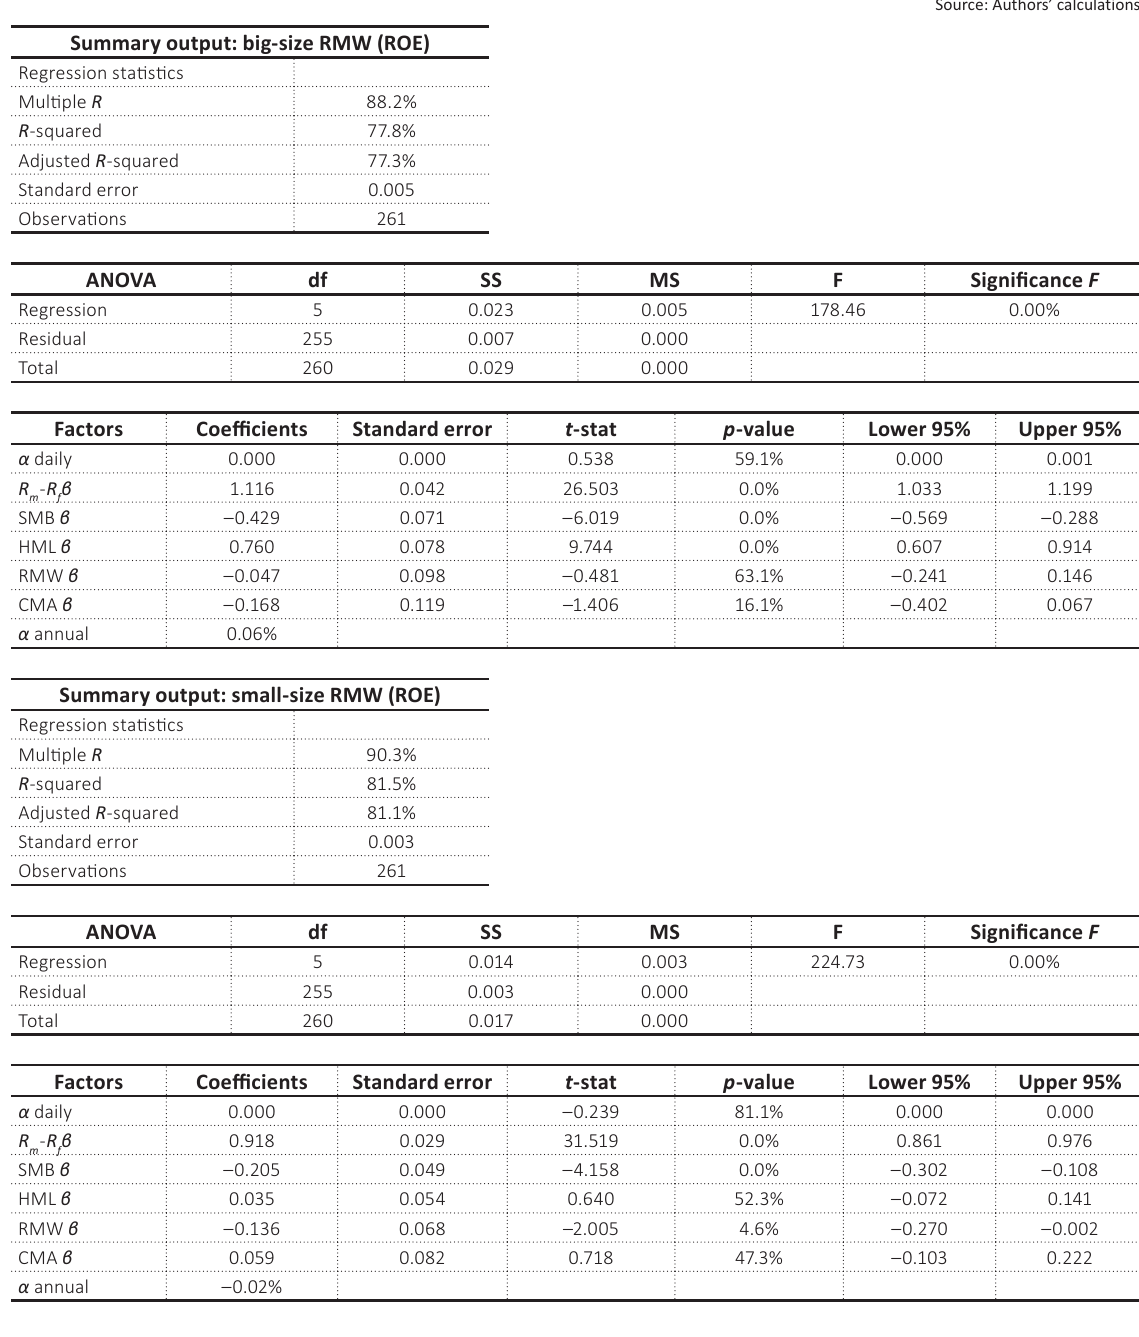
Table A2. ANOVA results for the RMW group portfolios